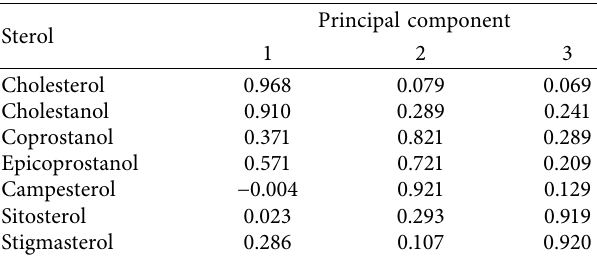
Table 8: Component factor matrix of principal component analysis of sterols in sediments of the Guanting